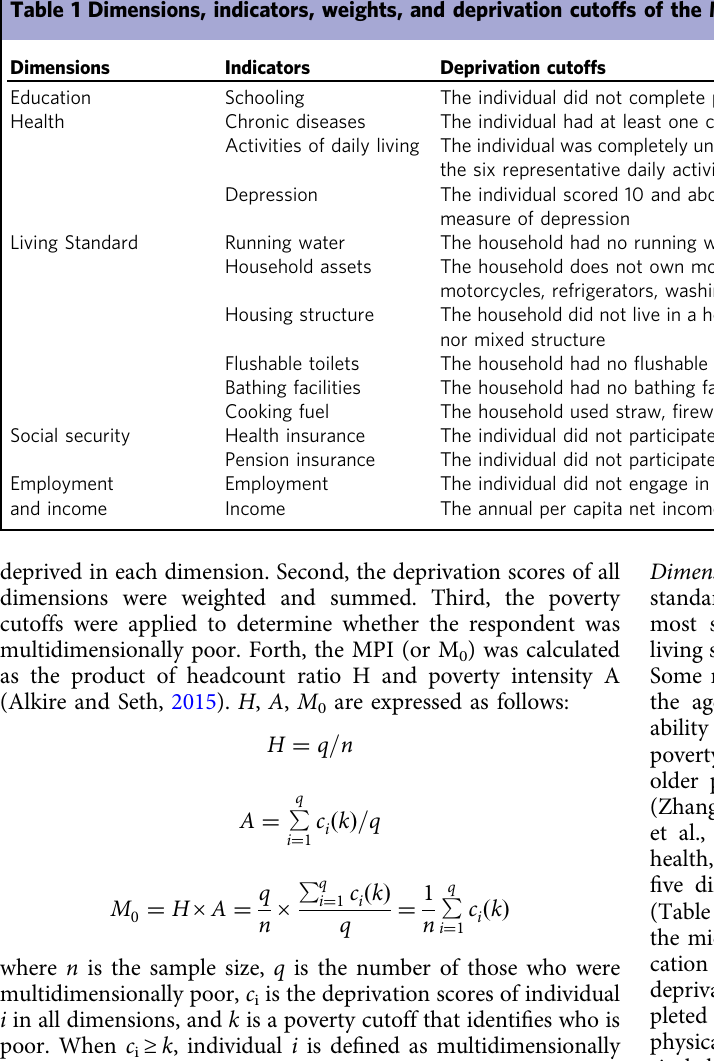
Table 1 Dimensions, indicators, weights, and deprivation cutoffs of the MPI